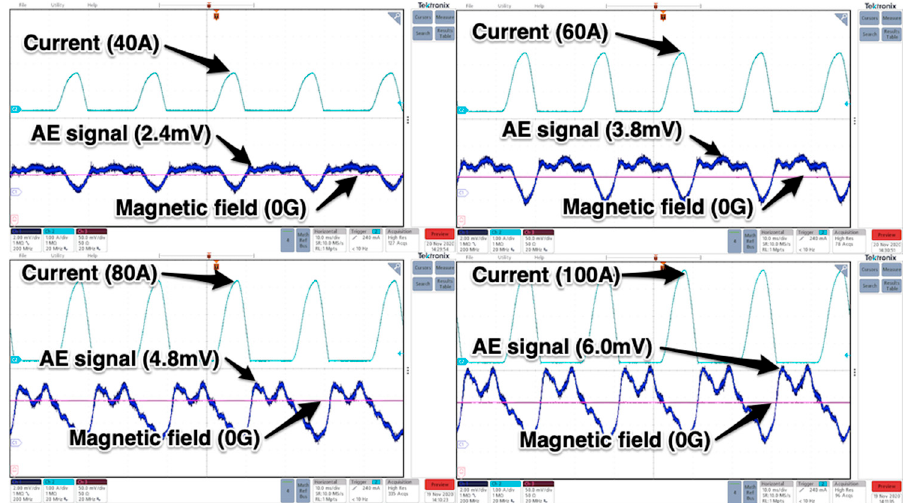
Figure 9. The chosen waveforms of raw AE signals (blue) detected by WS α transducer placed on the anode plate of conducting different currents (rectifying mode) GTO. Current and magnetic field waveforms placed for reference.